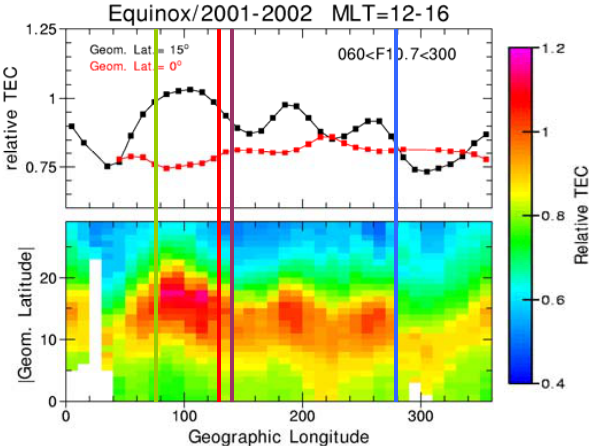
Figure 4a. Same as Figure 3a for June solstice Figure 4b. Same as Figure 3b for June Figure 3a. Average ExB drifts for Equinox Figure 3b. TOPEX relative TEC as a Fig. 3b. TOPEX relative TEC as a function of geographic longitude and magnetic latitude for Equinox 2001–2002 and 12:00–16:00LT (see text for details).